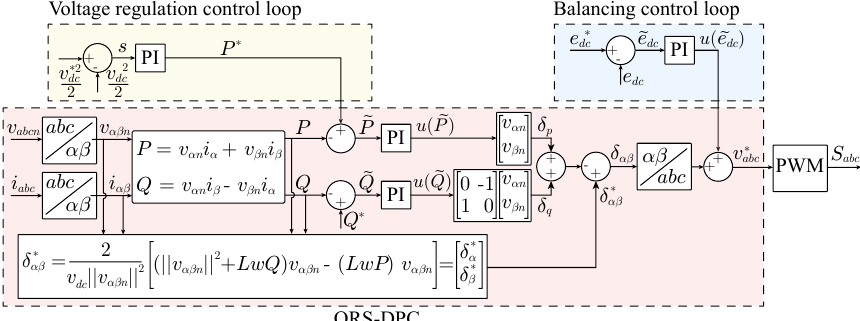
Figure 2. Traditional PI-based control scheme for three-level NPC converter in AFE